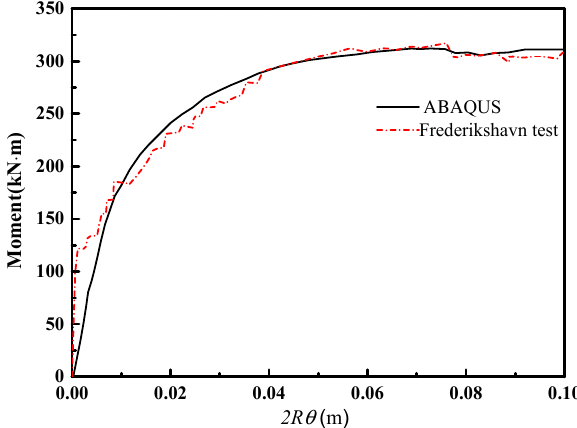
Figure 4. Comparison between numerical and large-scale tests at Frederikshavn [28].